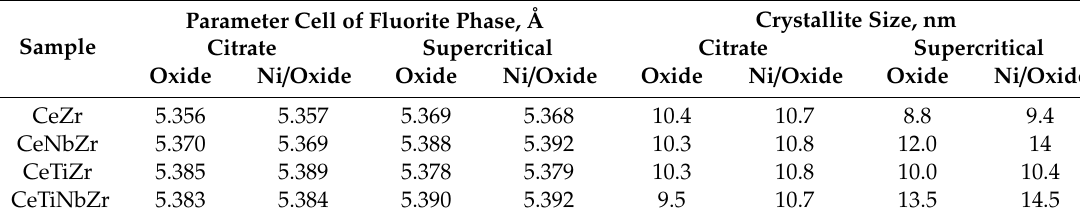
Table 3. Structural properties of samples according to XRD data.